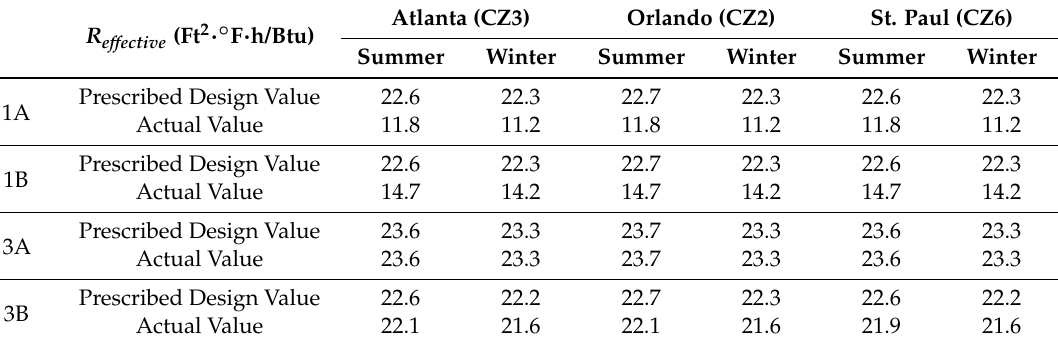
Table 6. Comparison of R effective Values showing the difference between Prescribed Design Conditions Case (baseline) and final assembly with taking into consideration, the effect of fasteners for all the climatic conditions analyzed.